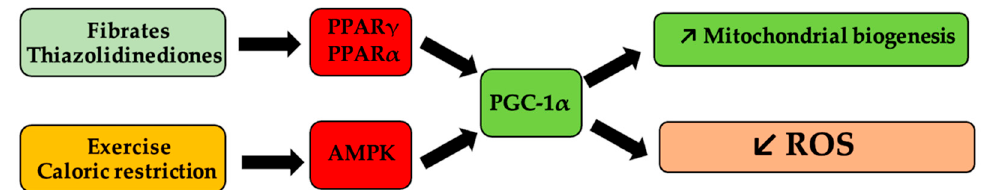
Figure 2. Schematic representation of mitochondrial biogenesis pathways of influence and of reactive oxygen species (ROS). Antihyperlipidemic medication, such as fibrates and antihyperglycemic medication, such as thiazolidinedione derivatives, activate peroxisome proliferator-activated receptor gamma coactivator 1-alpha (PGC-1 α ) via peroxisome proliferator-activated receptor γ and α (PPAR α , PPAR γ ), respectively, and determine the onset of mitogenesis and the decrease in ROS levels. Similarly, caloric restriction or physical effort, via activation of the same receptors, following the activation of 5 ′ protein kinase by the AMP (AMPK) pathway, lead to the same processes.